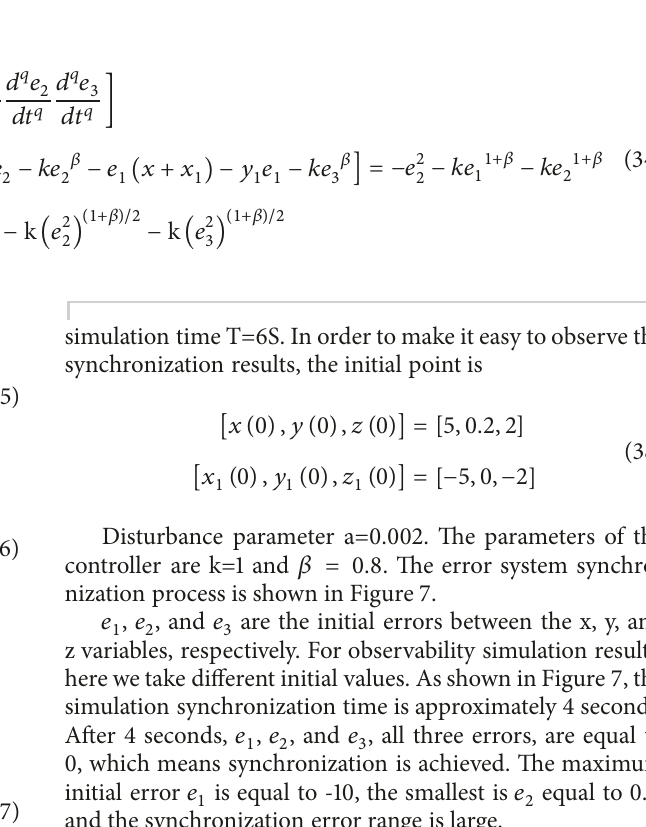
Figure 7: Curves of synchronous